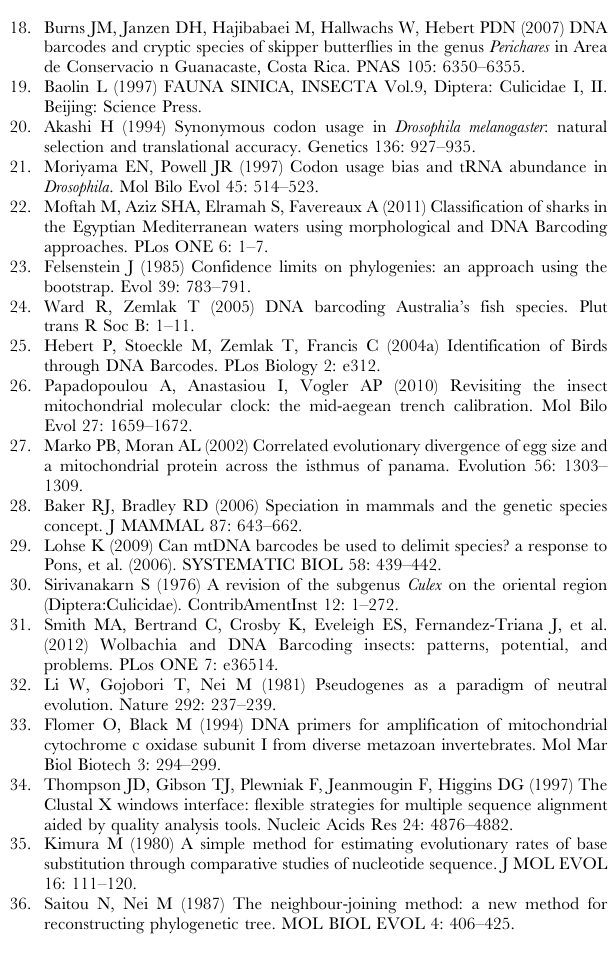
Species K2P distance